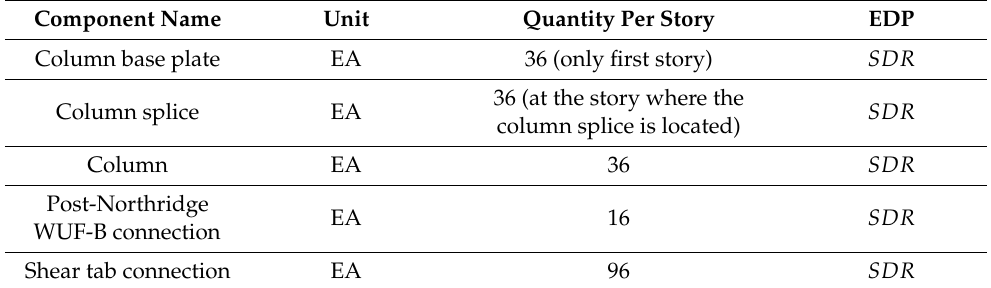
Table 3. The types and quantity per story for structural components of the model building.